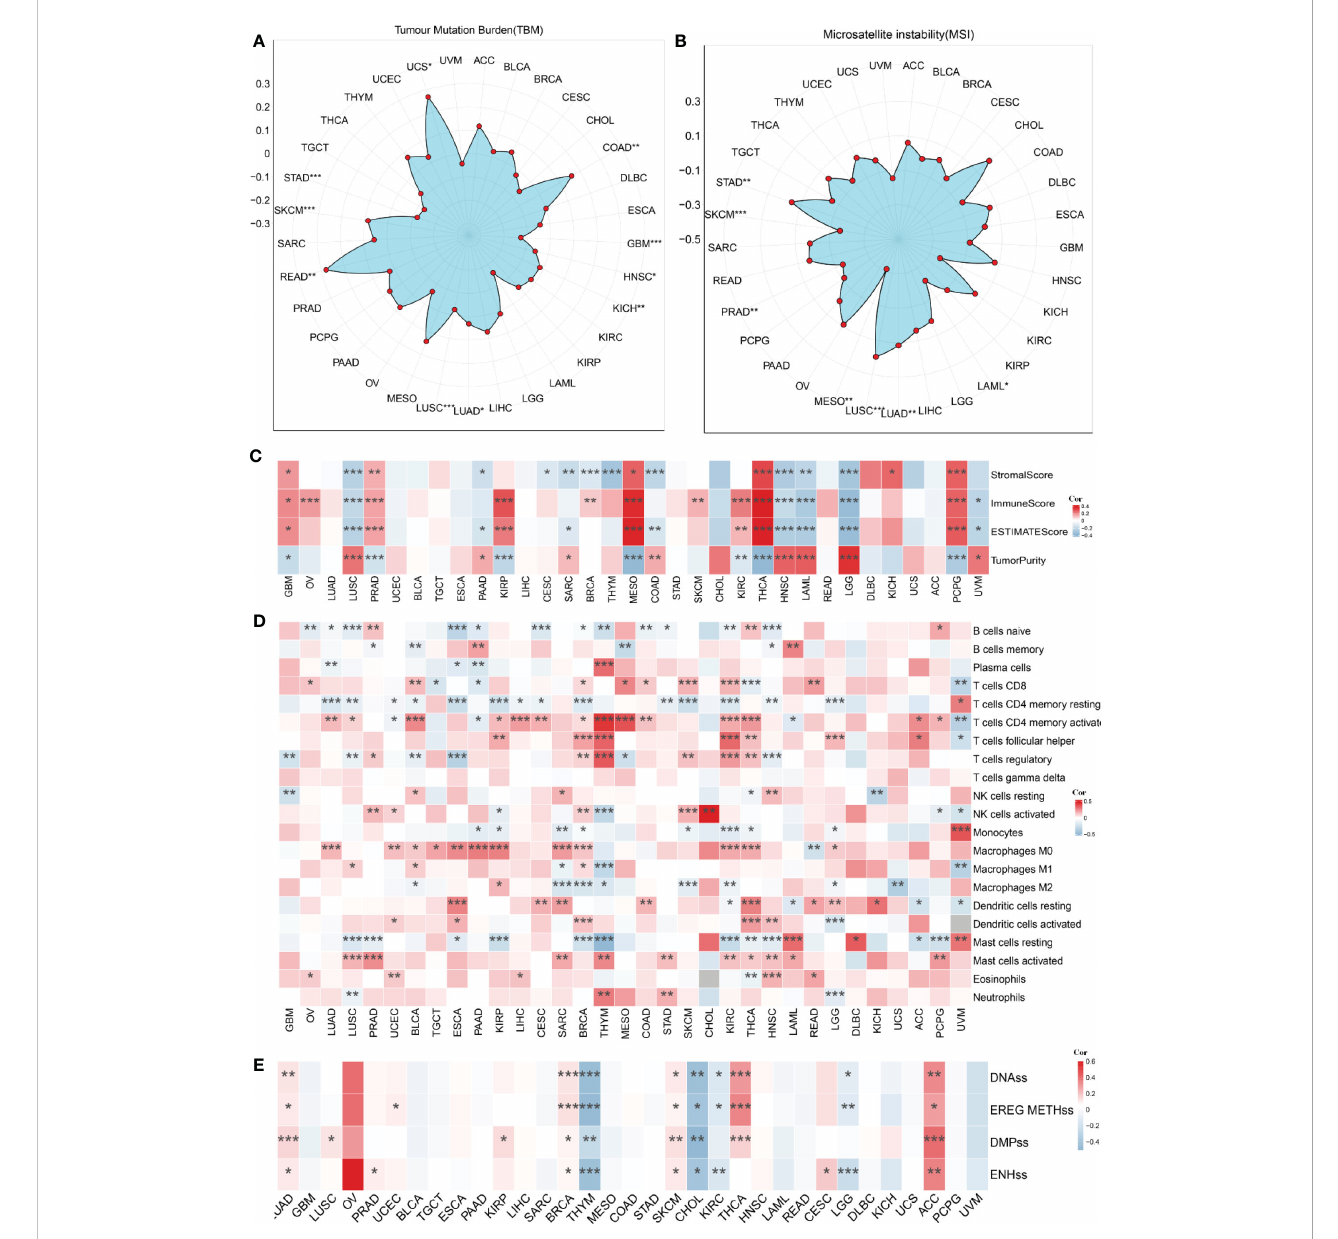
FIGURE 11 The pan-cancer analysis of the risk score model. (A) Tumor mutation burden (TMB), (B) microsatellite instability (MSI), (C) Tumor purity, ESTIMATES score, immune score, and the stromal score of 33 types of tumors. (D) The TME-in fi ltrating cell of 33 types of tumors. (E) The stemness index difference of 33 types of tumors. *p-value< 0.05, **p-value< 0.01, ***p-value<